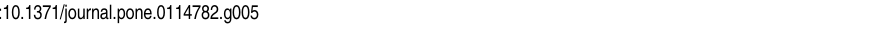
PLOS ONE | DOI:10.1371/journal.pone.0114782 December 8,